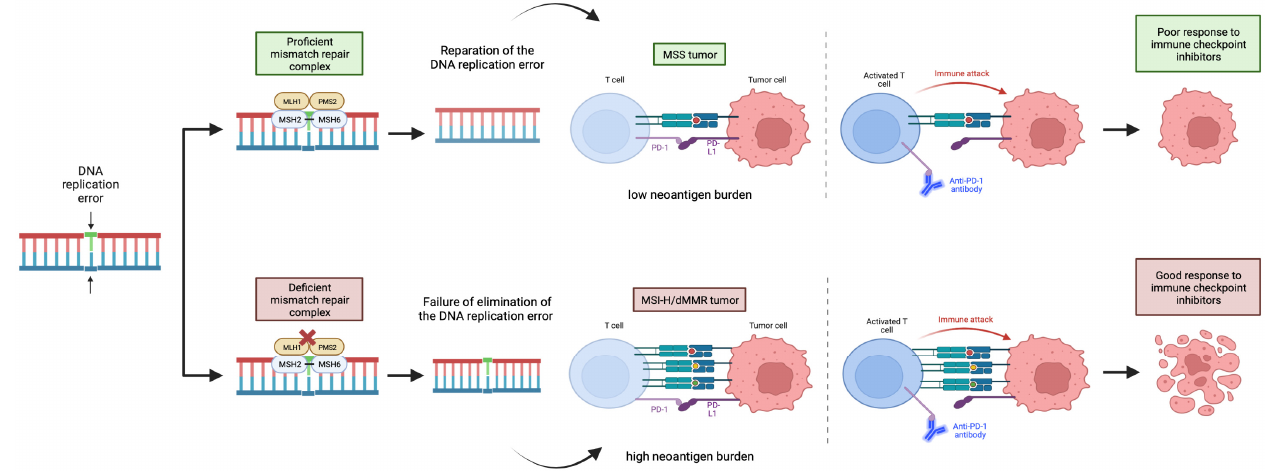
Figure 2. Overview of microsatellite stability and instability mechanism and response to immunotherapy. When the DNA mismatch repair protein complex is intact, DNA replication errors are repaired. MSS tumors have a low neoantigen burden, therefore blockade of the PD-1-PD-L1 interaction through immune checkpoint inhibitors results in low T-cell activation against tumor cells. In MMR deficiency, failure in the elimination of the DNA replication error leads to a high number of somatic mutations and neoantigens. This results in a stronger anti-tumor immune response and sensitivity to the immune checkpoint blockade.